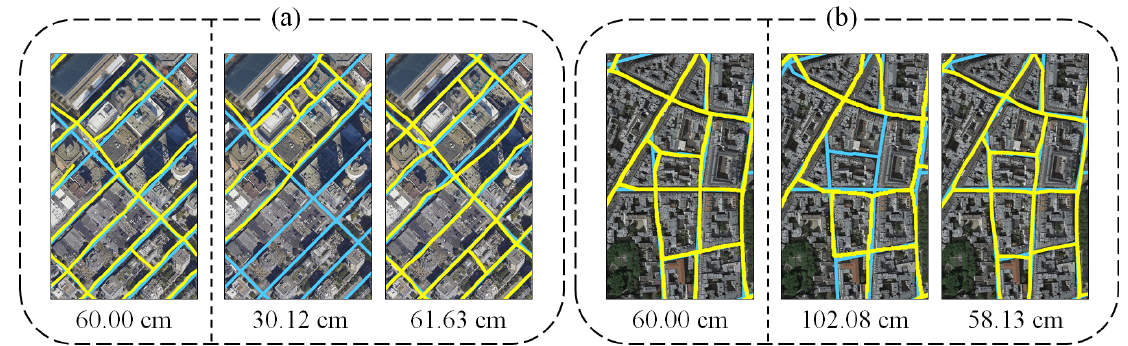
Figure 9. Results of RoadTracer [4] with different GSDs. The blue line shows the ground truth road, and the yellow line shows the predicted road. The first images in ( a , b ) have the fixed GSD of 60 cm. The second images have arbitrary GSDs with a range of 30 ∼ 120 cm. The third images are 60 cm resized versions of the second images, using the predicted GSDs. These images are cropped images from the original large images, which have the same coverage area but different image sizes because of different GSDs: ( a ) The predicted GSD is 29.33 cm; ( b ) the predicted GSD is 105.37